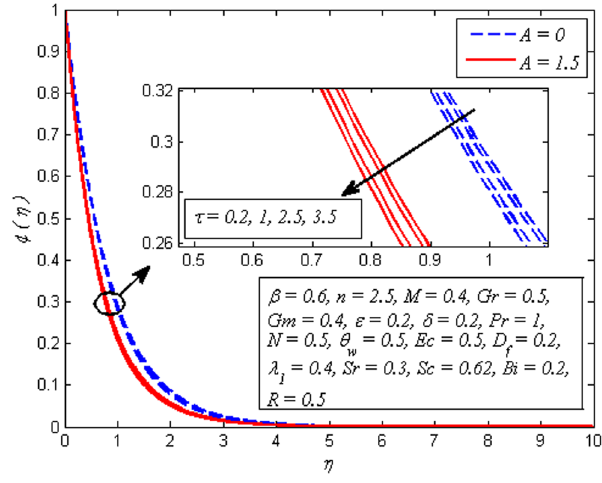
Figure 23. Effect of τ on concentration for different A